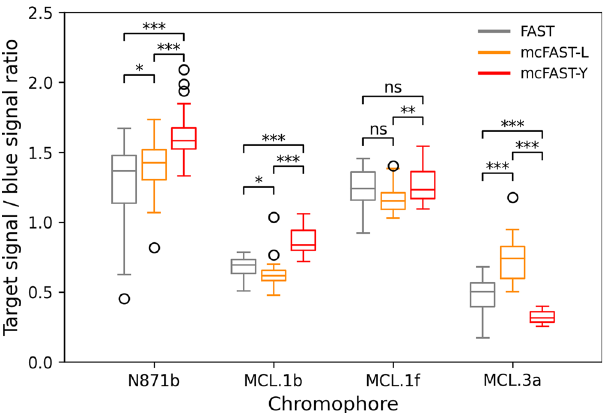
Fig. 3 In-cell brightness of FAST and its mutants. Comparison of relative brightness of FAST mutants with different chromophores in live HeLa Kyoto cells transiently transfected with H2B-TagBFP-FAST(or its mutants) constructs. Whiskers show standard deviation, horizontal lines indicate median values, and circles indicate outliers. n = 29 for each box. Stars indicate the p -values: * p < 0.05, ** p < 0.01, *** p < 0.001, ns p >